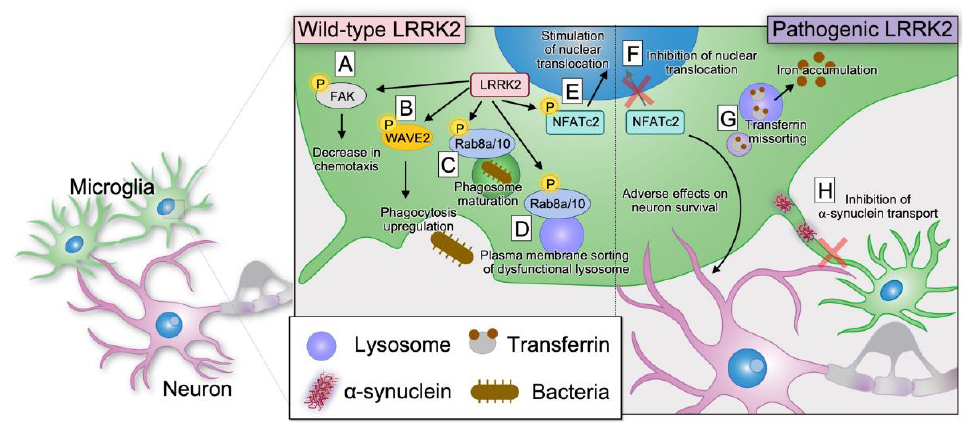
Figure 4. Reported roles of LRRK2 in microglia. ( A ) LRRK2 negatively regulates the migration of